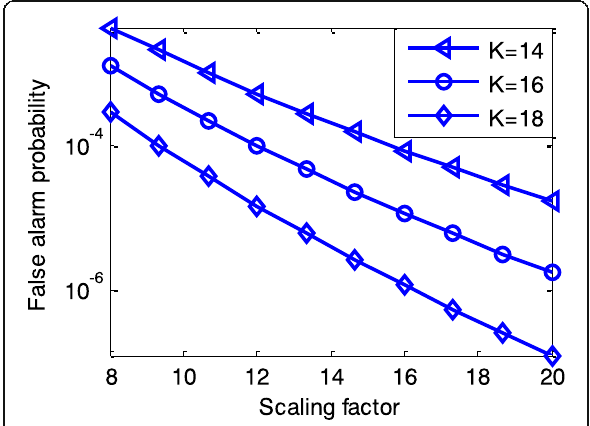
Fig. 5 Variation of the scaling factor α